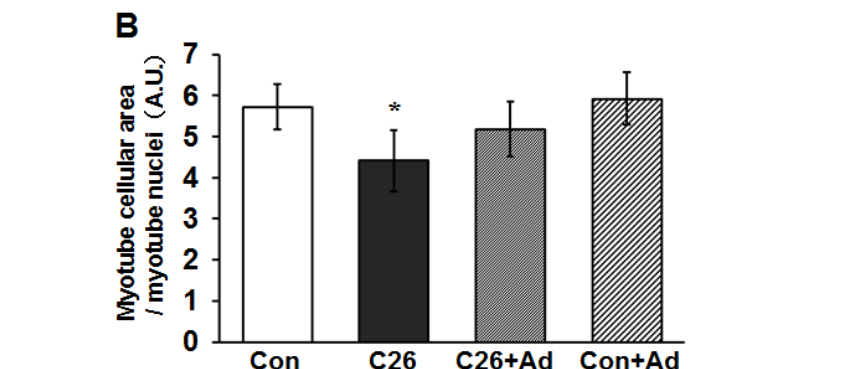
Figure 6. Adiponectin reverses the atrophy of myotubes caused by C26 conditioned medium. ( A ) Upper panels: C2C12 myotubes were treated with C26 derived conditioned medium (C26-CM) or 1 µ g/mL recombinant adiponectin as indicated for 48 h, and the cellular area of myotubes was visualized by MYH4 immunostaining (green). Nuclei were stained by Hoechst33342 (blue). Phase-contrast images of the corresponding area are shown in the lower panels. Bars: 50 µ m. ( B ) Relative multinucleated myotube areas per number of nuclei in the myotubes in ( A ) was analyzed. The bar graphs indicate the mean relative area ± SD. Statistical analysis was carried out using One-way ANOVA followed by Tukey HSD tests. *: p < 0.05, compared with control.